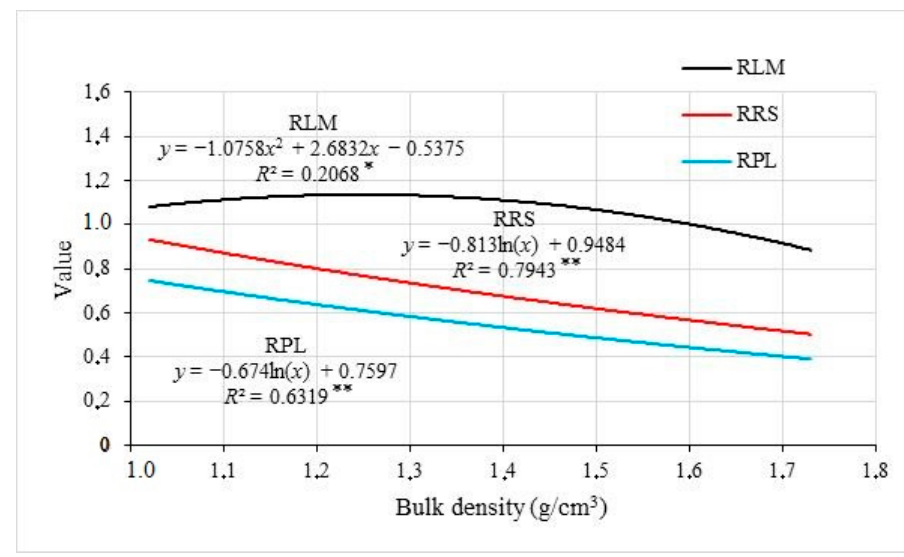
Figure 3. Relationship between RLM (ratio of lateral to main root length, RRS ratio of main root length to stem length, and RPL ratio of root penetration to main root length of beech seedlings with soil bulk density.